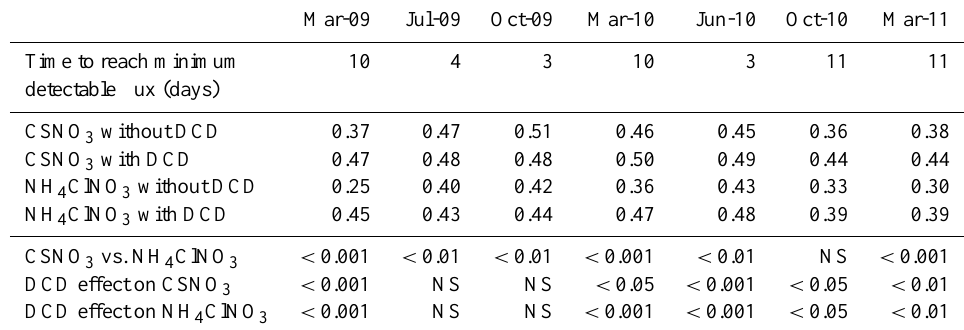
Table 3. The fraction of the 15 N-labelled nitrate pool ( a D ) for CSNO 3 and NH 4 ClNO 3 with and without DCD.